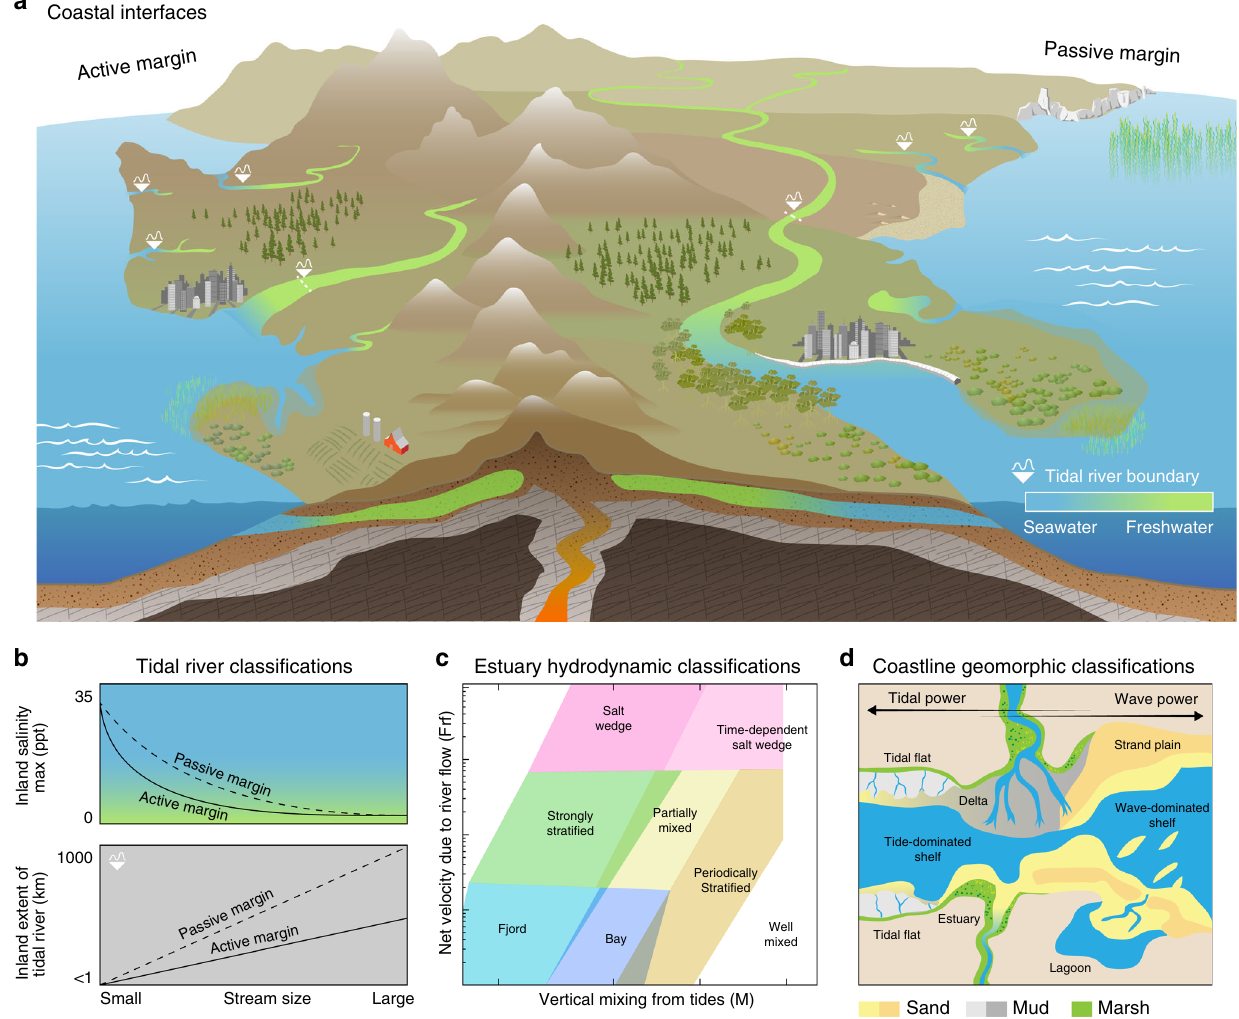
Fig. 2 Generalizable features of coastal ecosystems. a , b The inland extent of tidal in fl uence on river fl ow increases with stream order, while the inland intrusion of salinity decreases. Rivers (and groundwater tables) on an active continental margin (e.g., US West Coast) are generally steeper in elevation, reducing how far inland tides permeate. Gradients in vegetation are in fl uenced by these characteristics. c Estuarine environments can be broadly classi fi ed by their hydrodynamic properties such as net current velocity due to river fl ow (Fr f ) and how effectively tides mix a strati fi ed estuary (M); fjords have low freshwater and tidal velocity scales due to their great depth whereas salt wedges have high contributions from rivers and a wide range of tidal contributions (adapted from Geyer and MacCready 23 ). d Classi fi cations of shallow water depositional environments along the coast can be categorized based on the ratio of wave power to tidal power and whether they are regressive (i.e., net land gain; top half of the diagram) or transgressive (i.e., net land loss; bottom half of the diagram) environments. The top half of the diagram shows regressive environments such as deltas and strand plains. The bottom of the diagram shows transgressive environments such as estuaries and barrier lagoons. Open coast tidal fl ats and shelf environments can be linked to either type of coast with shelf width decreasing during regression (adapted from Steel and Milliken 107